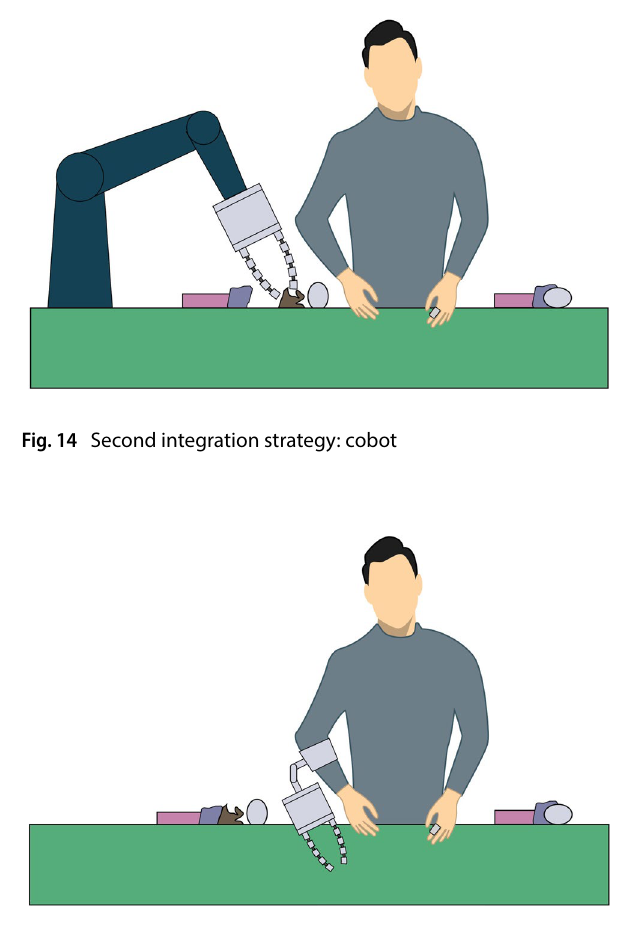
Fig. 15 Third integration strategy: auxiliary